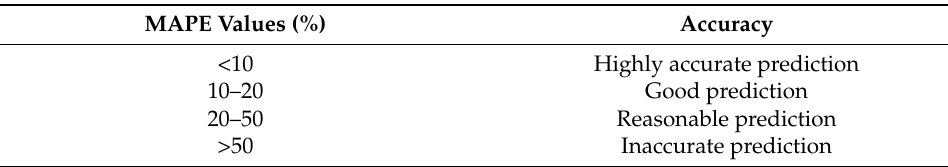
Table 4. Levels of forecasting accuracy measured by MAPE